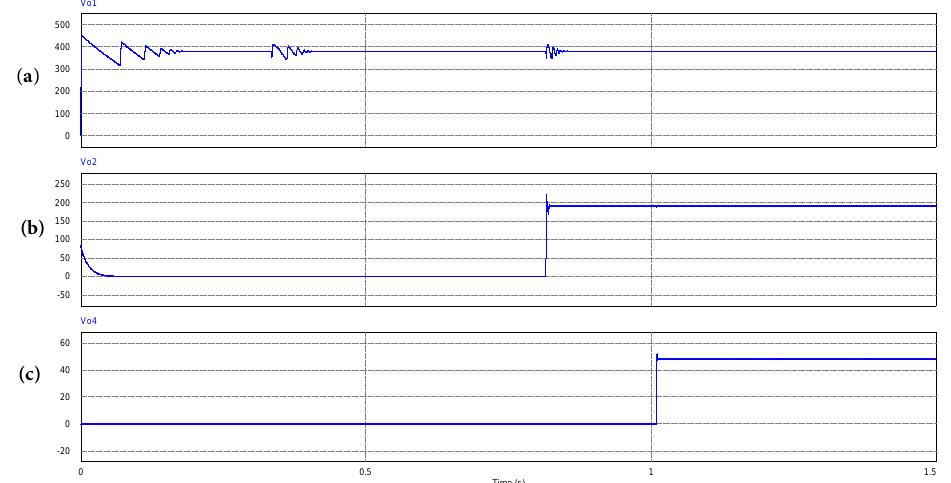
Figure 28 . Waveforms are: in Figure 28a, principal bus voltage and Figure 28b, 1.2 kW converter output voltage are used like time references; Figure 28c shows current input electronic load enabled at 0.5 s, some ripple can be seen caused by loads dynamic in secondary bus. More results are presented in Figure 29.